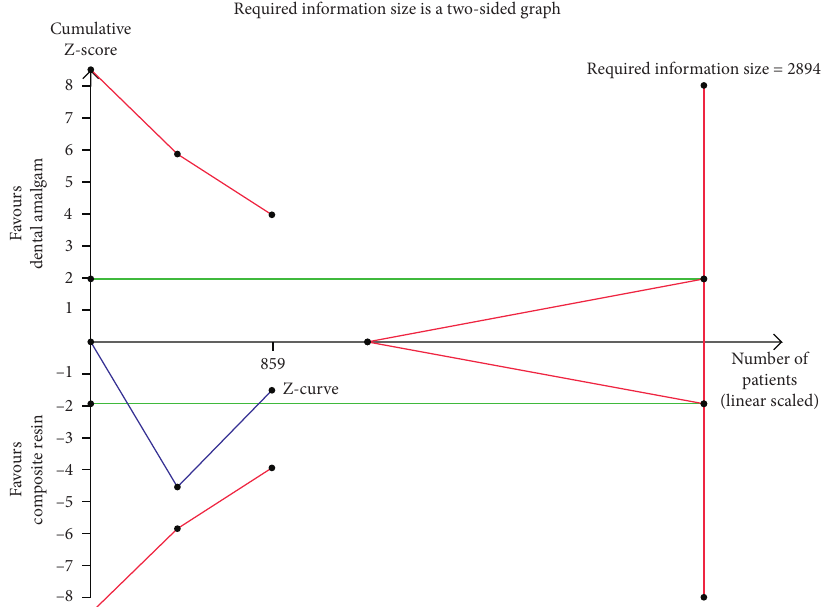
Figure 5: Trial sequential analysis for urinary mercury concentration after 5 years of exposure to dental amalgam or composite resin in